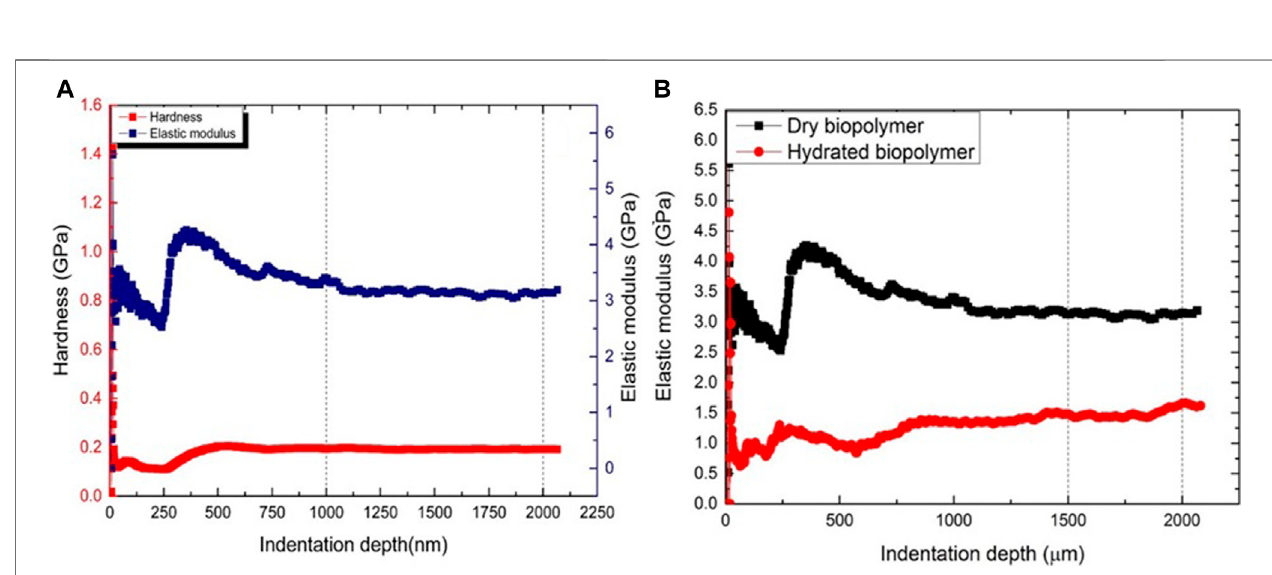
FIGURE 7 | (A) Elastic modulus and hardness as a function of the penetration depth (B) Variation in modulus of dry and hydrated biopolymer sample.